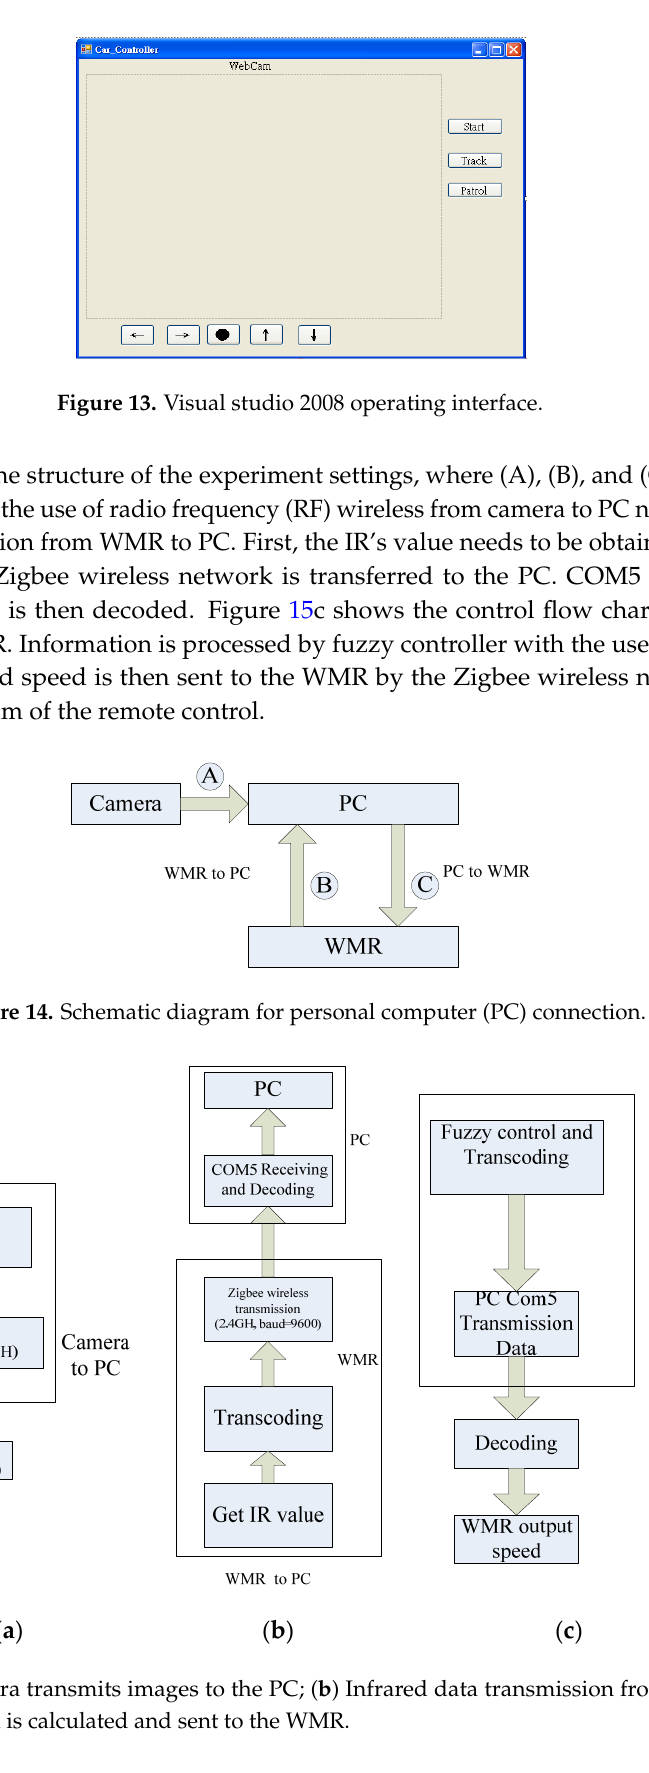
Figure 12. Experiment setup.